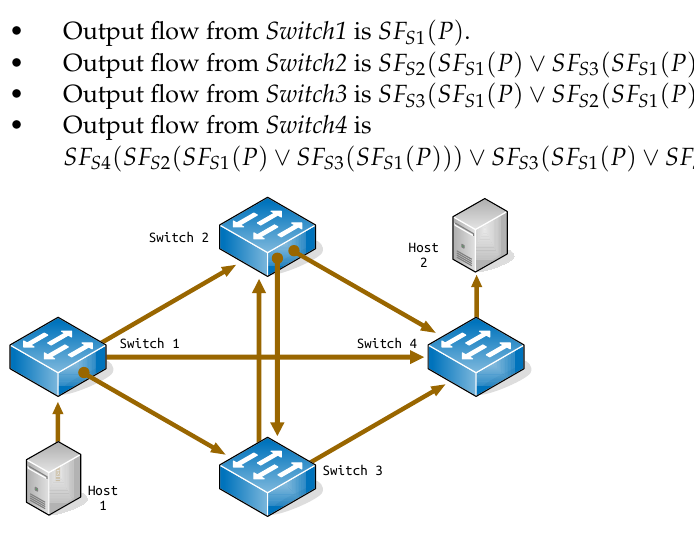
Figure 5. An example network ( M NET ) with mesh